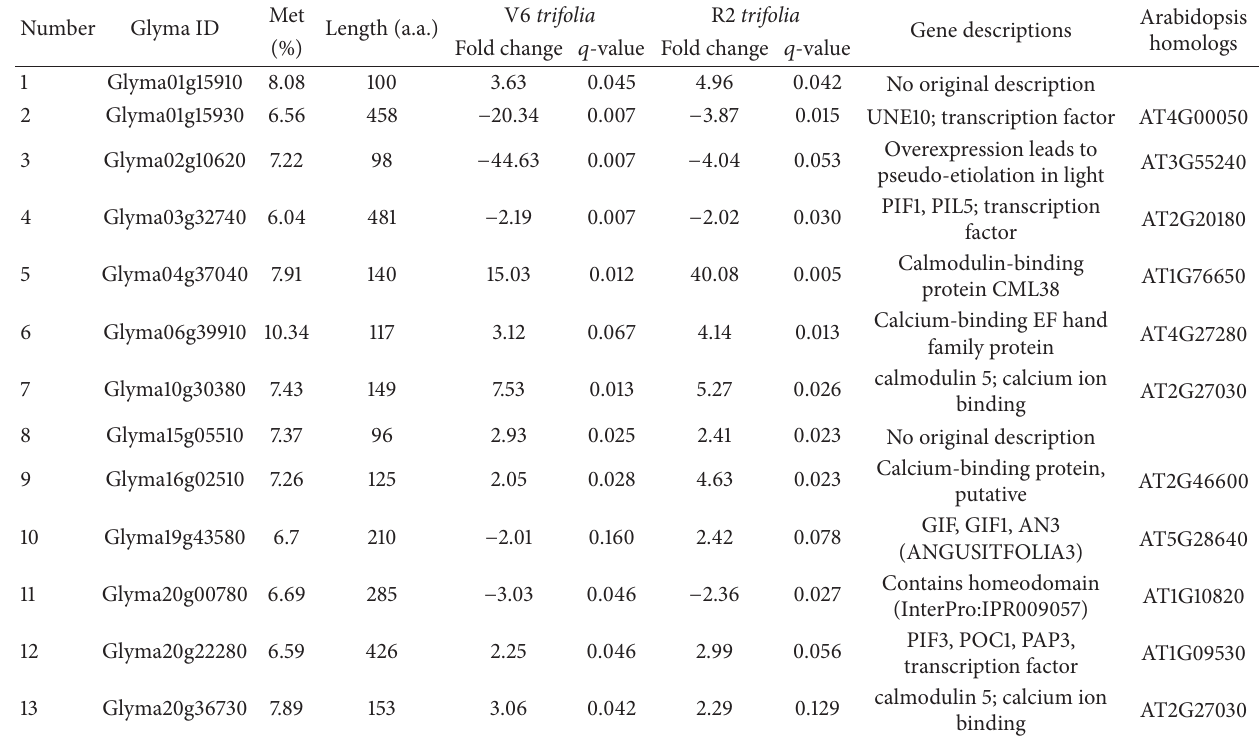
Table 2: Genes encoding GmMRPs whose expression is responsive to drought stress in V6 and R2